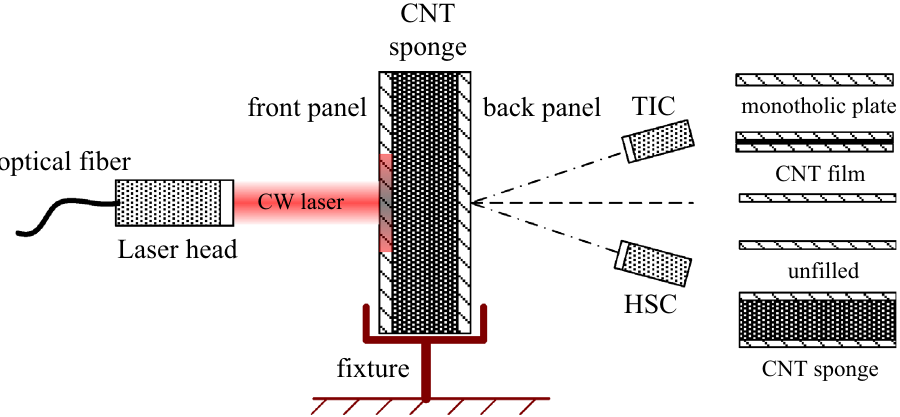
Figure 1. Schematic of the experimental setup and the types of specimens tested in the